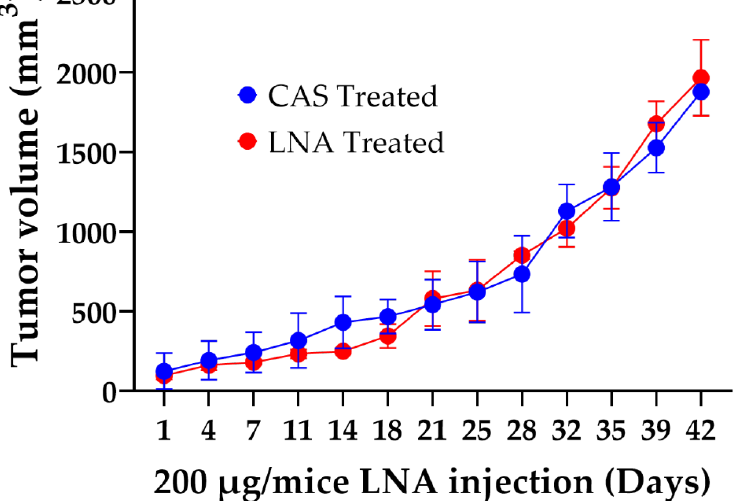
Figure 4. Effect of Rlip-LNA on growth rate of PyVT tumors. Tumor growth was monitored twice weekly, and the tumor sizes were determined using a caliper as described in materials and methods. The graph shows the growth of tumors in the control anti-sense (CAS) and treated (Rlip-LNA) groups. Results are reported as mean ± SD ( n = 5 each group).